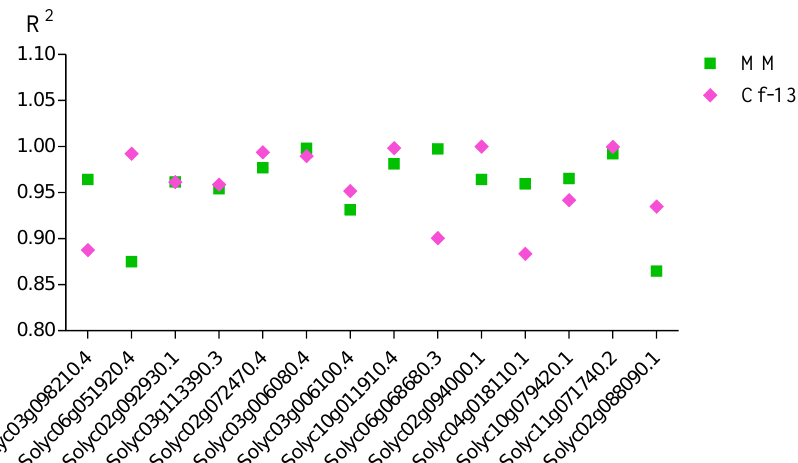
Figure 5. Correlation coefficients between the RNA-seq and qRT–PCR results. The expression patterns for both Cf-13 (0, 9, and 15 dai) and MM (0, 9, and 15 dai) were analyzed for each gene. The results obtained from both methods (RNA-seq and qRT–PCR analysis) were used to calculate correlation coefficients (R 2 values). MM: Moneymaker; Cf-13 : Ont7813.